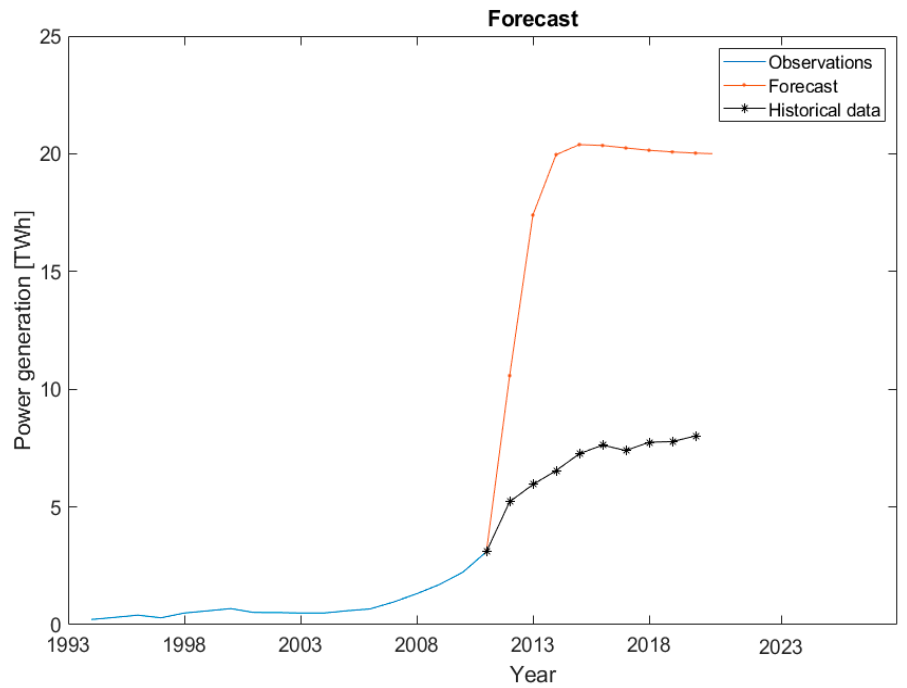
Figure 9. Prediction for renewable energy production with extended state aid.